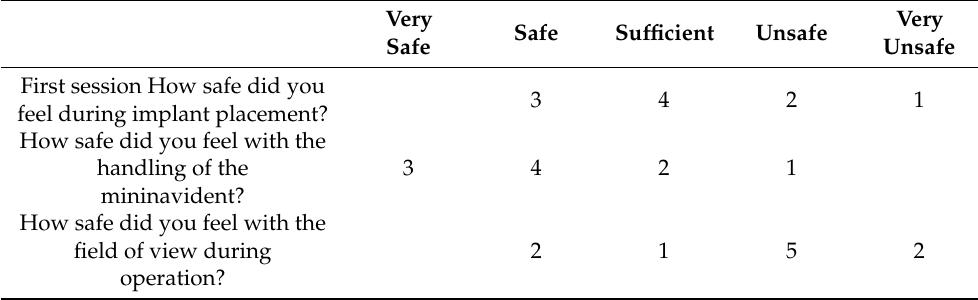
Table 2. Responses of the ten students regarding subjective reliability in using a dynamic computer- assisted surgical system in dental implant placement (first session). Table 3. Responses of the ten students regarding subjective reliability in using a dynamic computer- assisted surgical system in dental implant placement (second